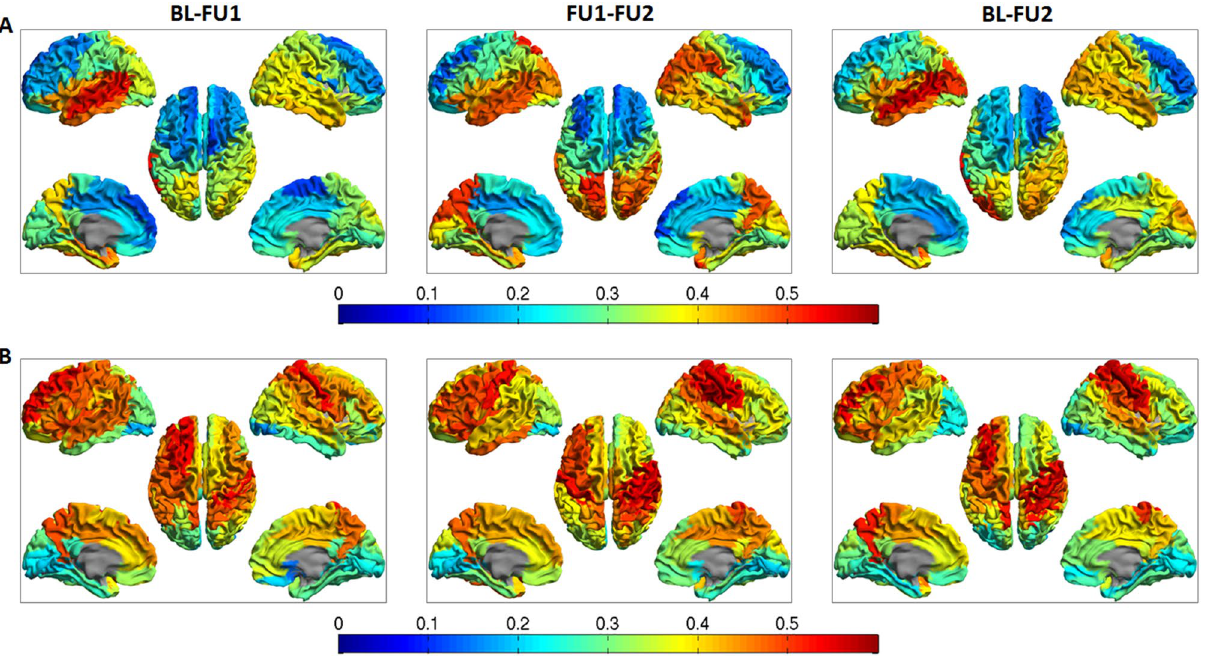
Figure 4. Functional connectivity analysis; region of interest-specific display. Distribution of within-subject functional connectivity correlation values displayed on a parcellated template brain viewed from, in clockwise order, the left, right, left midline, and right midline. For alpha band functional connectivity, the correlation values were highest in the parieto-occipito-temporal cortical brain regions ( A ). For beta band functional connectivity, the correlation values were highest for the central and frontal brain regions ( B ). The subcortical regions had an intermediate level of correlation, both for the alpha and beta band functional connectivity (not